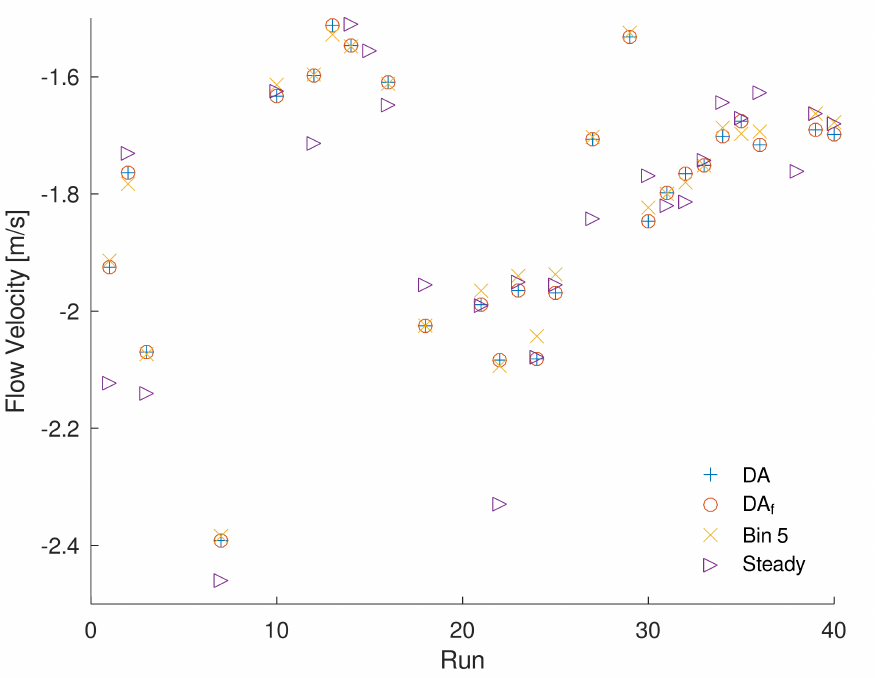
Figure 13. Comparison of raw depth–averaged data ( DA ) from Aquqadopp 1 from the entire timetrace, compared to filtered data ( DA f ), data from only a single bin ( Bin 5) and the depth– averaged values obtained from the steadiest 30 s section ( Steady ) according to Vector 1.